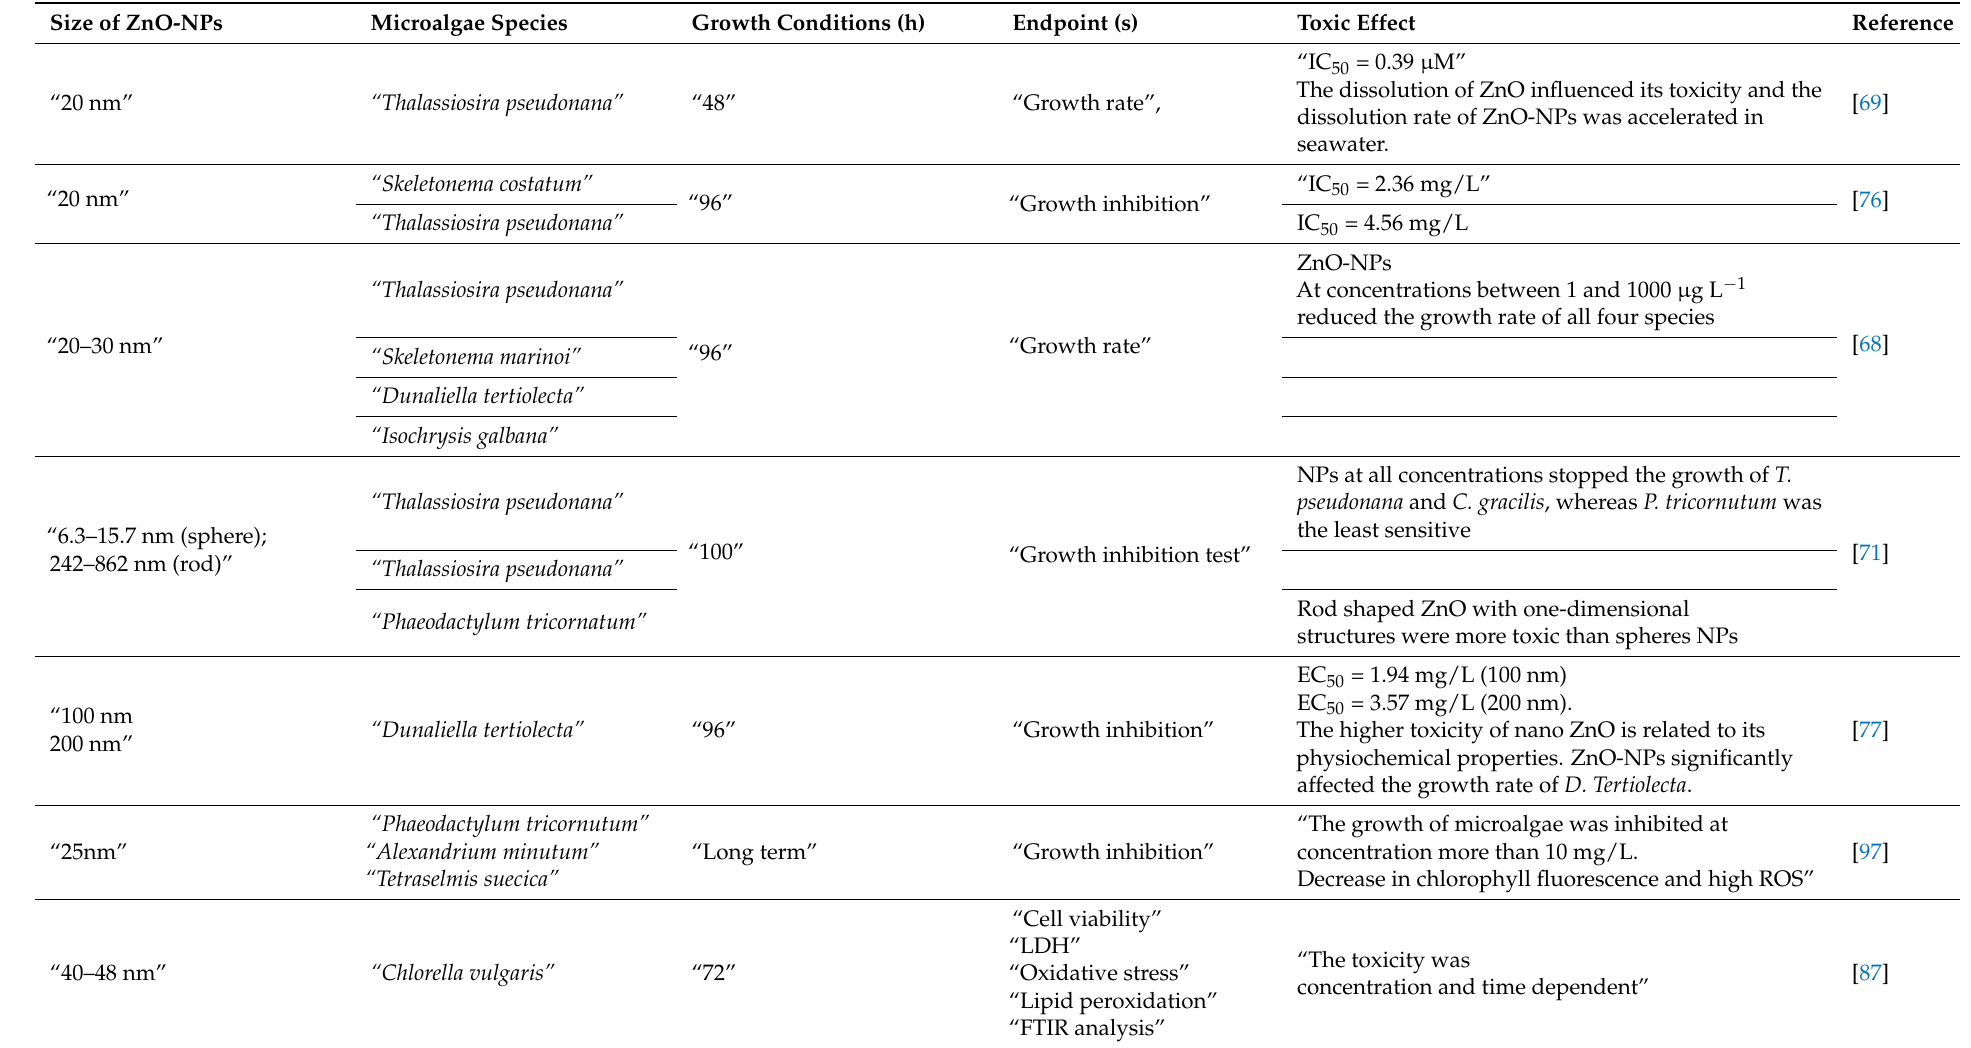
Table 2. Toxic effects of several ZnO-NPs on various marine algae under various